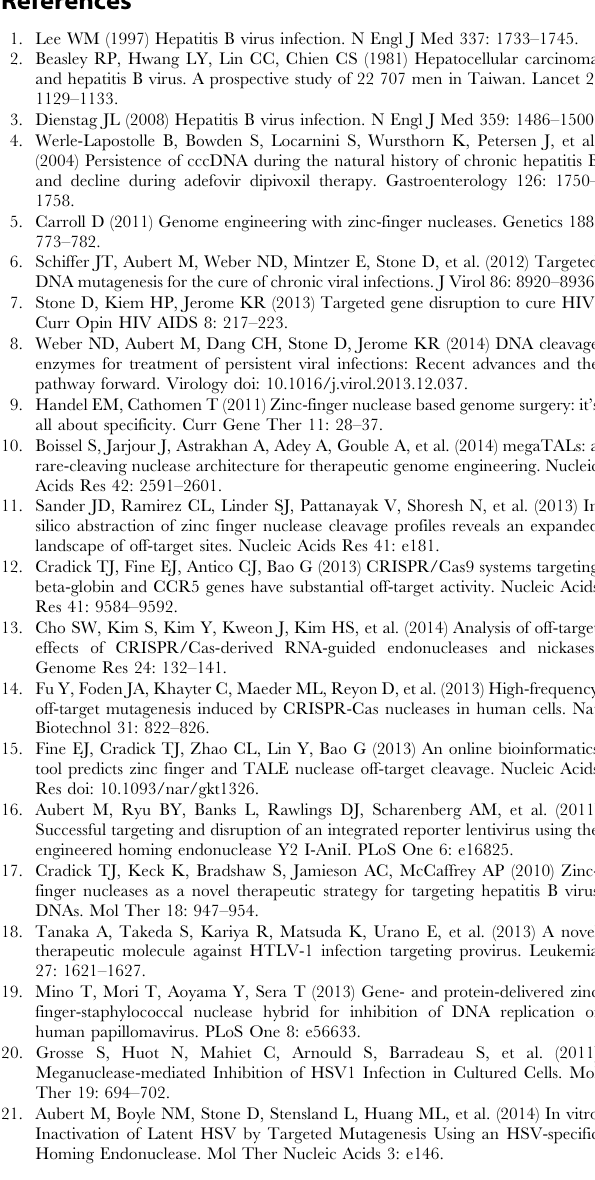
site in blue. Logo plots and consensus sequences were obtained with the use of GeneiousPro. ZFN – zinc finger nuclease. (TIF) Figure S2 Instances of indels in off-target site spacer regions. Alignments with wt reference sequences of the 4 sequence reads of off-target sites containing indels in the spacer region. These were taken from a total of 9290 total reads of off- target sites obtained from PCR amplicons generated from DNA from cells that had been treated with ZFN-expressing scAAV2 vectors as indicated. Spacer regions are underlined. wt – wild type; ZFN – zinc finger nuclease. (TIF) Table S1 PCR primer sets. (DOCX) Table S2 Three on-target and 7 off-target ZFN sites. *Target sequence, red underlined nucleotides show spacer regions, lowercase letters show mismatches from HBV sites, blue